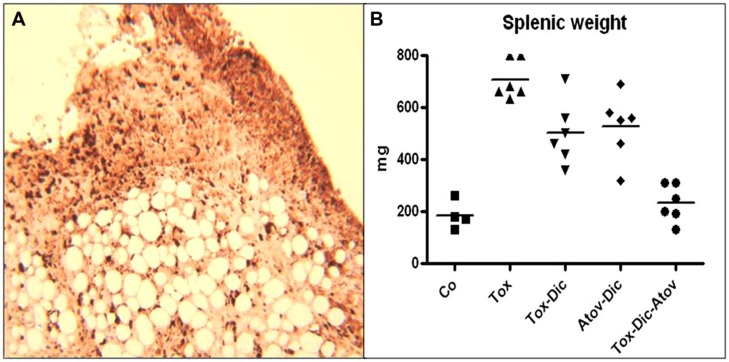
(A) Demonstrates inflammatory fat depot located in abdominal cavity and harboring numerous organisms. IHC stained Toxoplasma organisms (dark brown). (n = 6 group). (B) Spelenic weight distribution in Toxoplasma (Tox) infected (p < 0.001) compared to diclazuril (Dic) monotherapy (p < 0.01), atovaquone (Atov), synergistic effect of diclazuirl plus atovaquone (Dic + Atov) combination therapy (p < 0.001) and normal sham controls (Co). (n = 6/group).